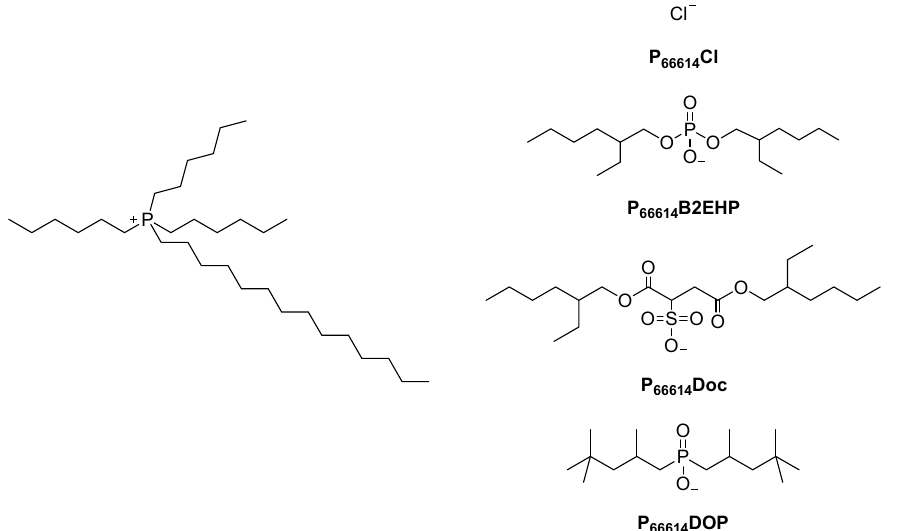
Scheme 1. Hydrophobic ionic liquids evaluated for PGM separation.